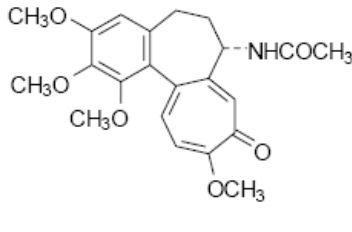
Colchicine, N-((7S)-5,6,7,9-tetrahydro-1,2,3,10-tetramethoxy-9- oxobenzo(a)heptalen-7-yl)-